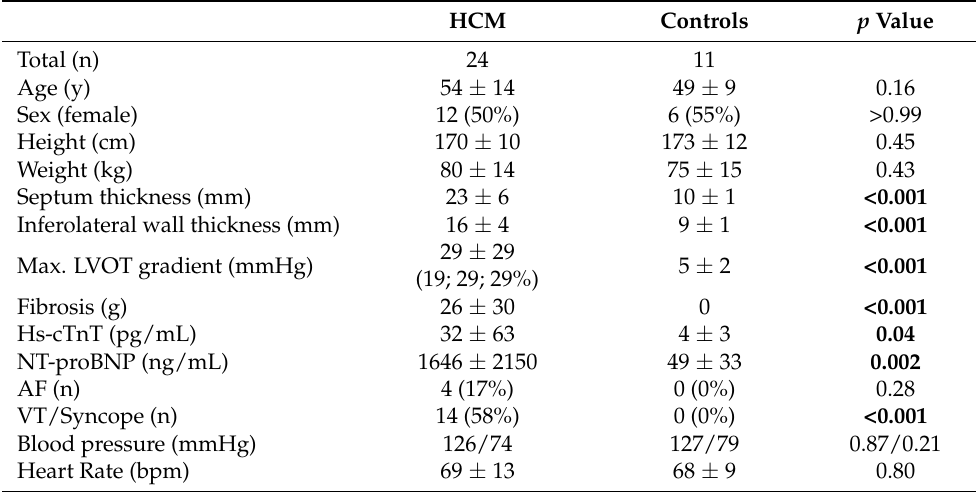
Table 1. Baseline characteristics of patients with HCM and healthy